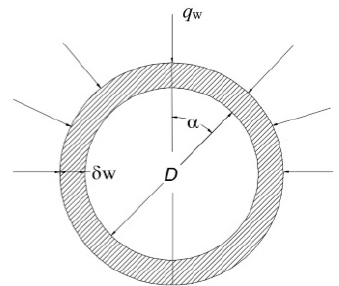
Figure 2. Geometry and boundary condition.